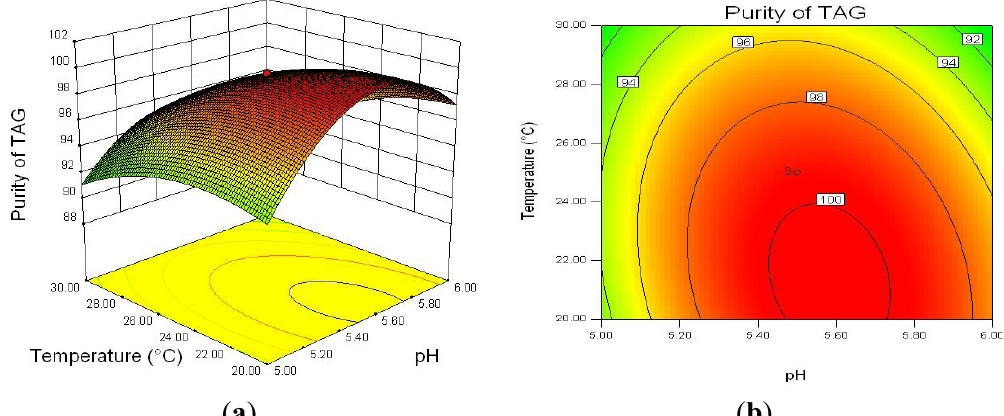
Figure 5. Response surface plot ( a ) and its contour plot ( b ) of the TAG purity; temperature vs. pH with a constant level of water content